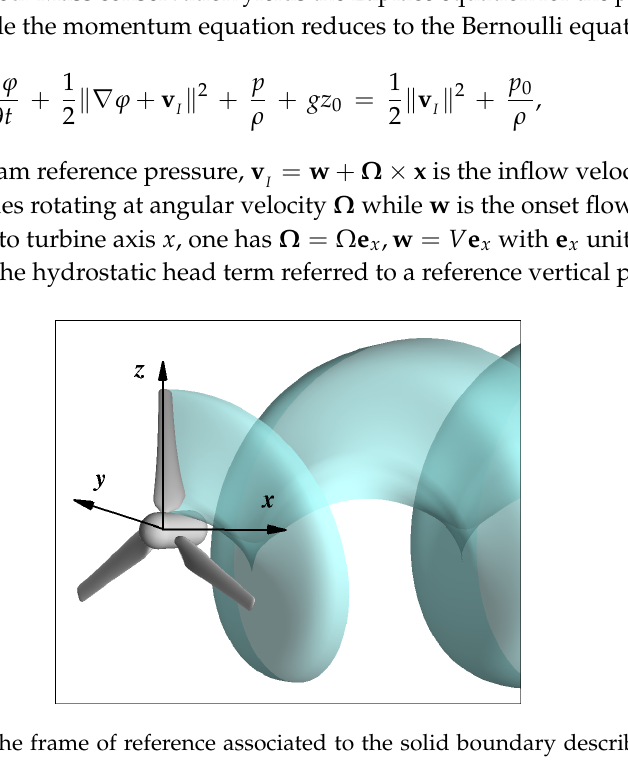
Figure 1. Sketch of the frame of reference associated to the solid boundary describing an isolated turbine and the surface of trailing wake shed by one